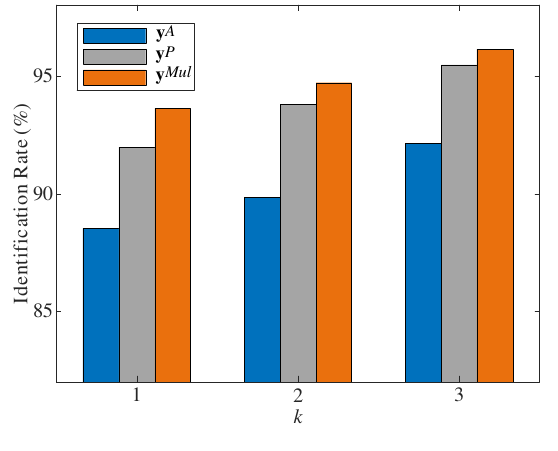
Figure 6. Identification rates for different k